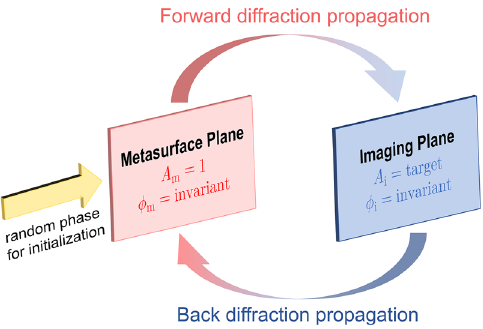
Figure 1: The flow chart of iterative Fourier-transform algorithms (IFTA) method for phase retrieval of a metasurface plane. Electric field propagates to the imaging plane from the metasurface plane with a random phase and unit amplitude as initialization, and the amplitude A i is replaced by the target pattern while the phase ϕ i keeps invariant. The fi eld then propagates back to the metasurface plane and the amplitude A m is replaced by unit. The process above runs iteratively until A i is consistent with the target